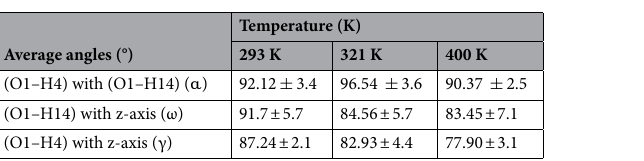
Table 4. The average angle values between dipole moments of the bonds involved in the interactions.